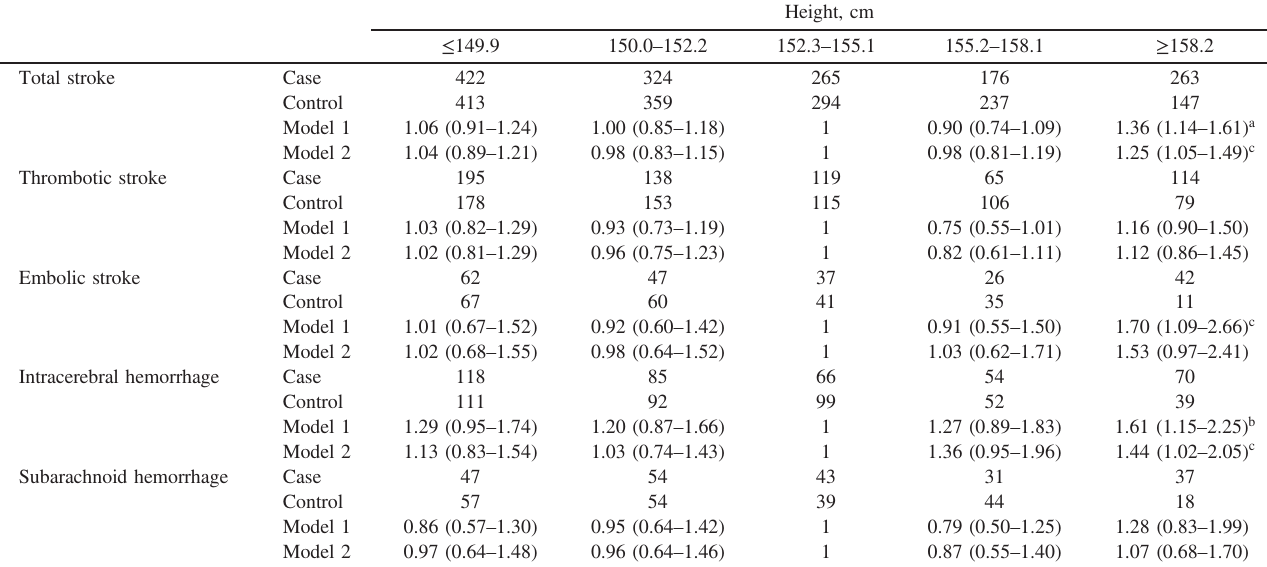
Table 4B. Multivariable-adjusted odds ratios and 95% con fi dence intervals of stroke and its subtypes according to height in women aged 60 – 79 years, Aichi,